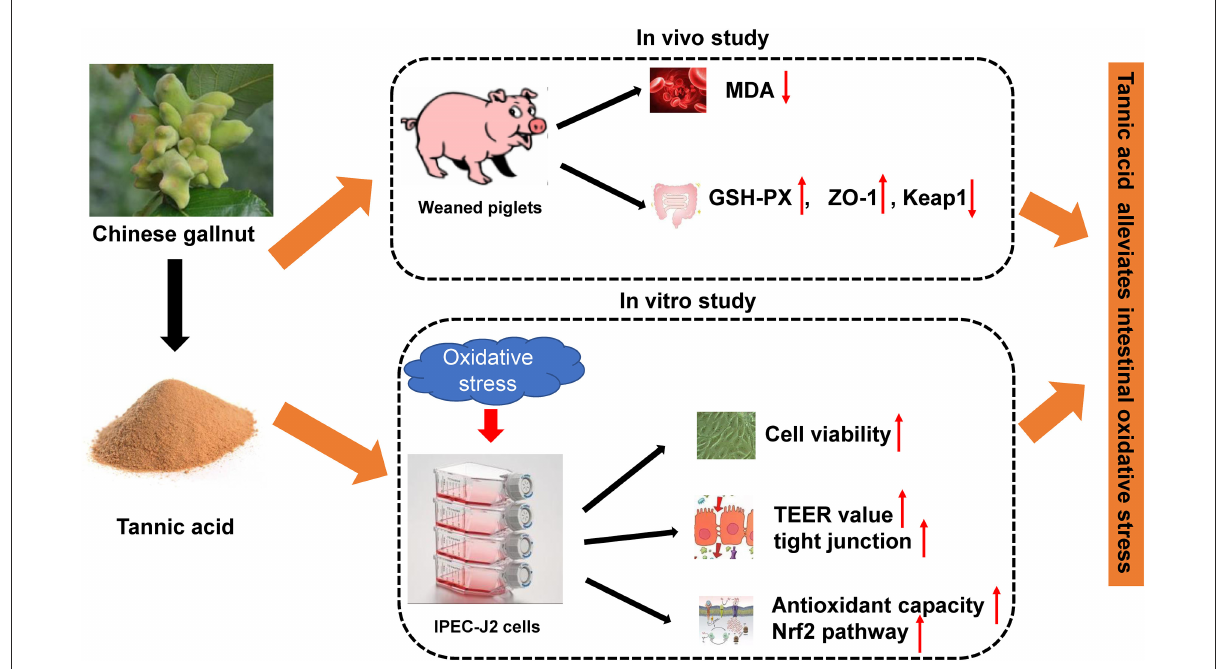
FIGURE9 A model of tannic acid alleviating intestinal oxidative